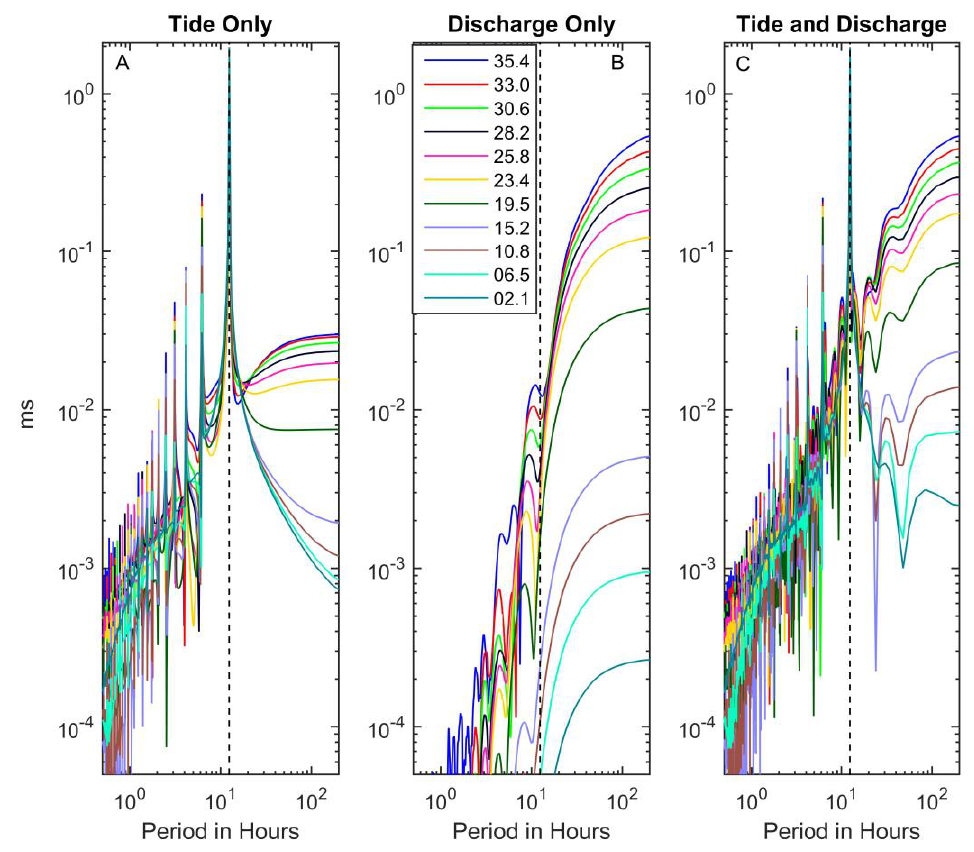
Figure 8. Spectra from Fourier transform of runs ( A ) I7, ( B ) I1, and ( C ) I5. Black dashed line indicates M 2 tidal frequency.